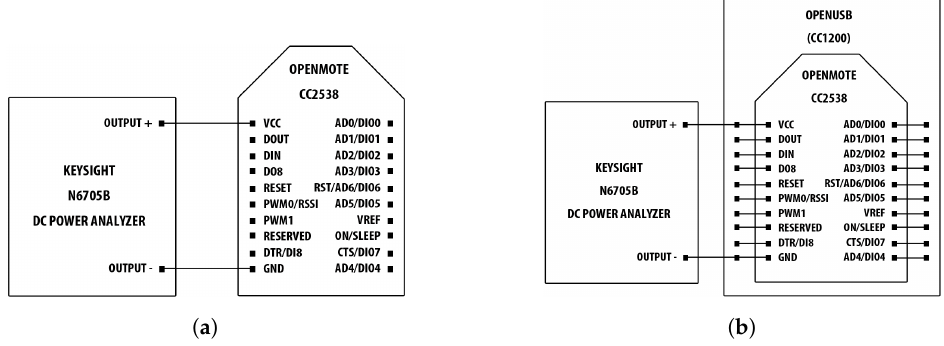
Figure 5. Energy consumption measurement setups: for the 2.4GHz measurements, only the OpenMote-CC2538 was used, while for the 868GHz measurements, the power analyzer was connected to the OpenUSB to which the OpenMote-CC2538 was attached. ( a ) 2.4GHz measurement setup; ( b ) 868MHz measurement